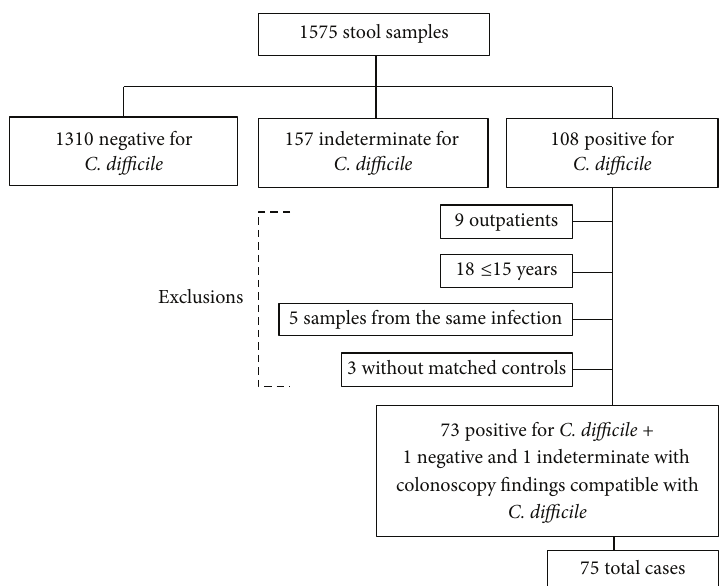
Figure 1: Flow chart showing enrollment of the study patients. ∗ 1310 toxin-negative samples belonged to 1244 patients. ∗∗ 157 toxin- indeterminate samples belonged to 149 patients. ∗∗∗ 108 toxin-positive samples belonged to 103 patients.